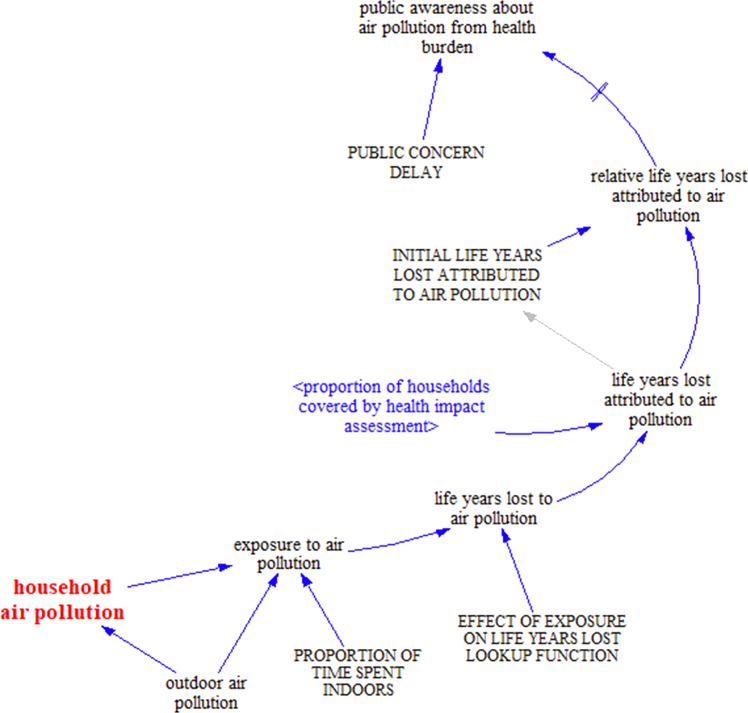
Formulation of life years lost to air pollution.